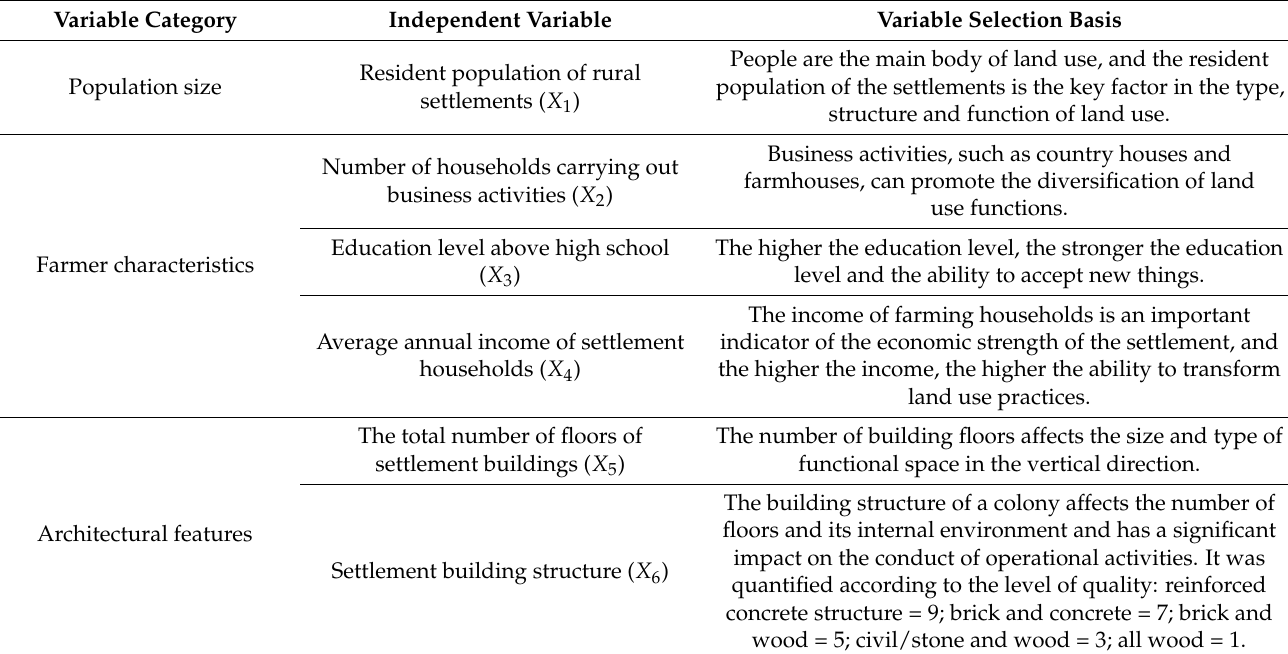
Table 5. Socioeconomic influencing factor variables and selection basis of the levels of